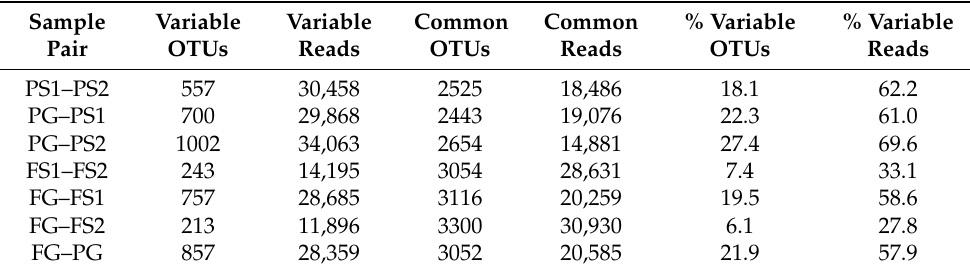
Table 2. Results of the pairwise sample comparisons, including information about the abundance of taxa in the